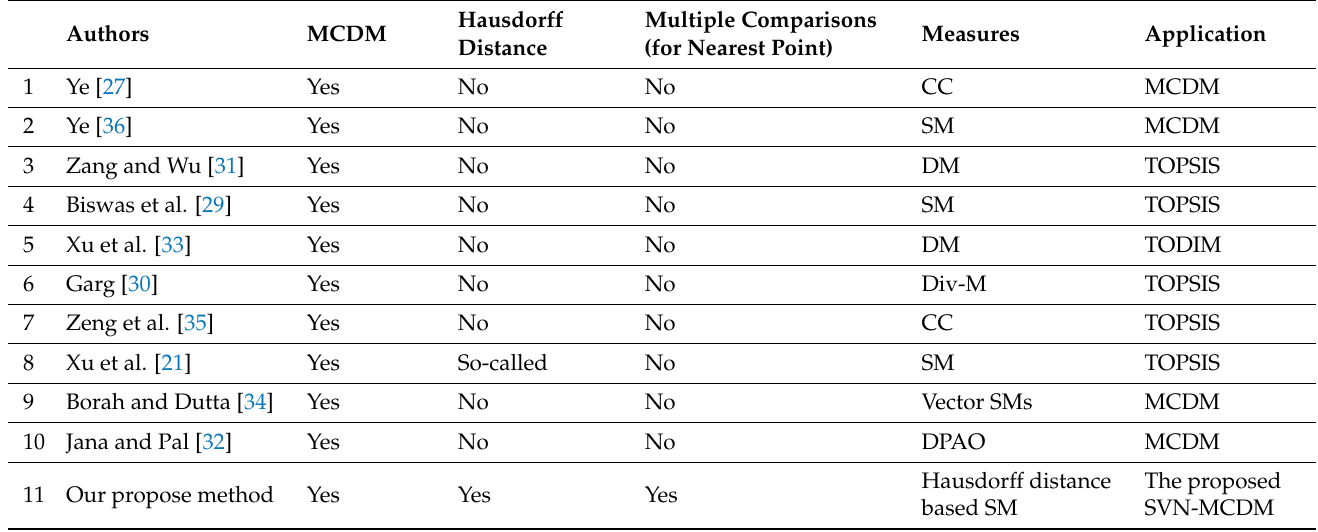
Table 1. Different measures and contributions regarding MCDM and Hausdorff